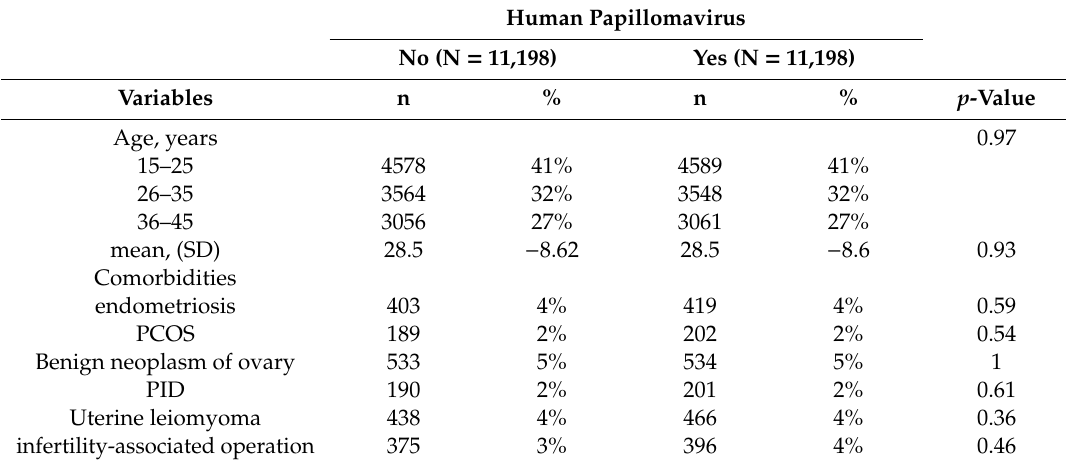
Table 1. Baseline characteristic of patients with and without